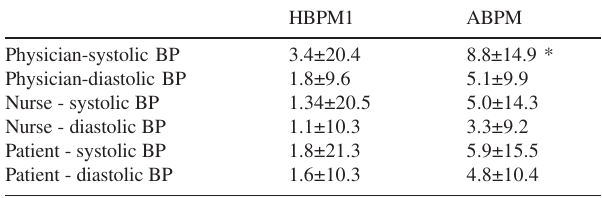
Table 4 - White Coat Effect (mean ± standard deviation) - differences between measurements taken by a physician, a nurse and the patient/ family member in the office, and ambulatory (ABPM) and home (HBPM1) blood pressures.